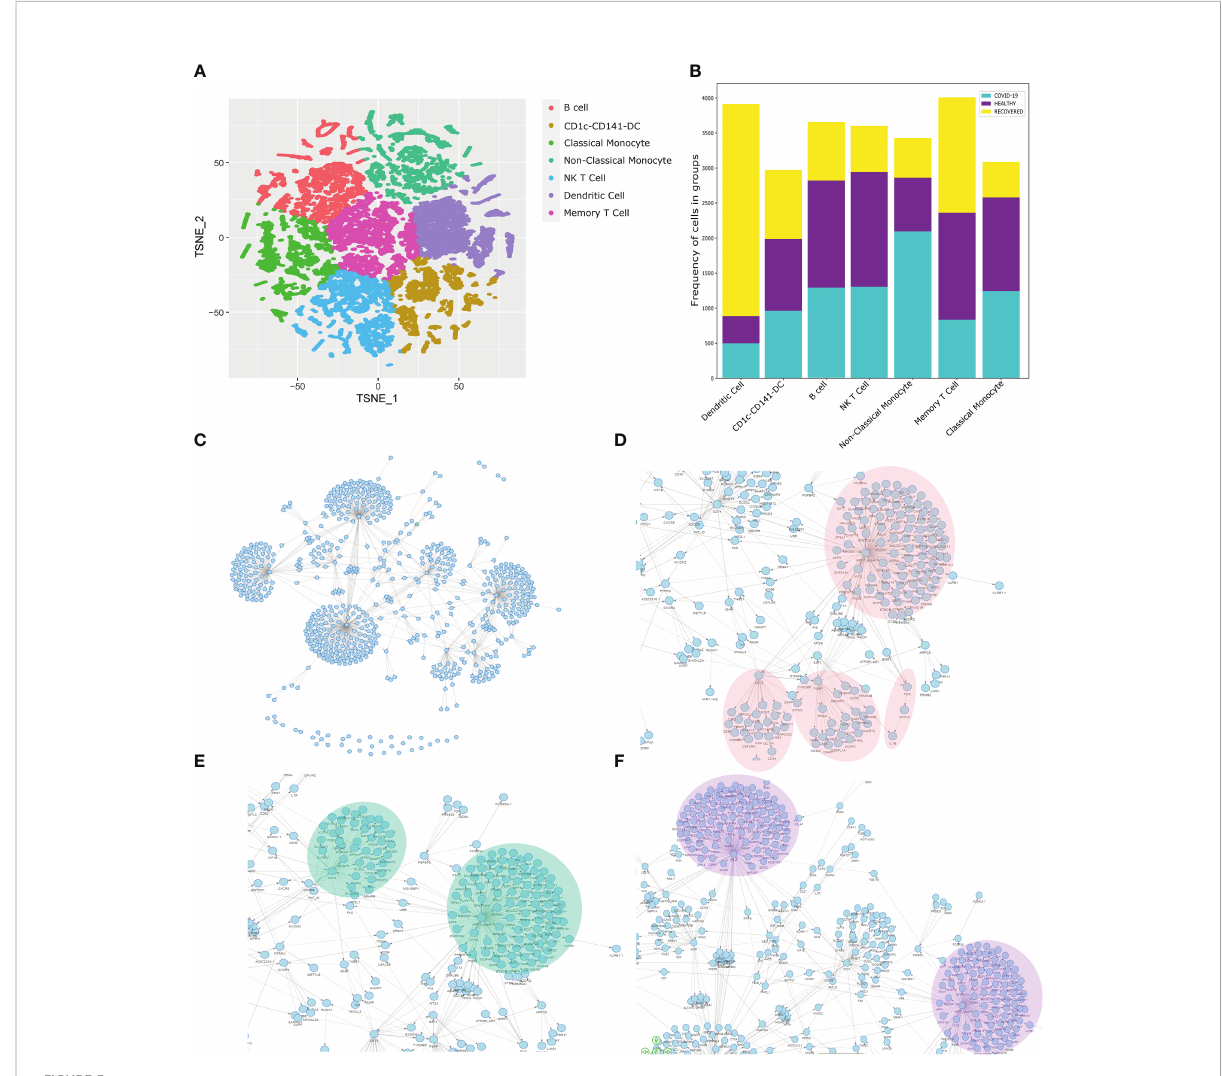
FIGURE 5 Similarity Network Fusion and Bayesian Network Model for Biomarker discovery. (A) SNF clustering of cells based on the gene expression, surface marker expression and clinical details of the individuals. (B) Distribution of the identi fi ed cell types across the healthy, COVID-19 positive and recovered individuals. (C) Bayesian Network Model built on the SNF clusters, gene expression, surface marker expression, and clinical data including the HRCT score of the individuals. (D – F) Speci fi c highlights from the Bayesian Network Model showing the association of HRCT score with (D) FOS, CST3, PSAP , (E) CD74 , and (F) CD45